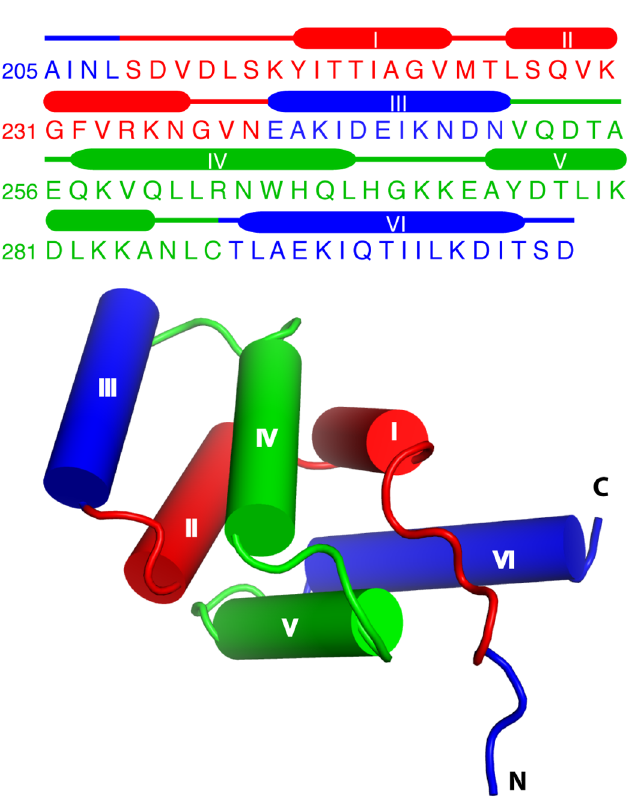
Fig 1. FasDD sequence and structure. Protein sequence, secondary structure and a cartoon representation of the three-dimensional structure of FasDD (PDB ID: 1DDF). The CaM-binding regions (Fas- Pep1 and Fas-Pep2) are highlighted in red and green,